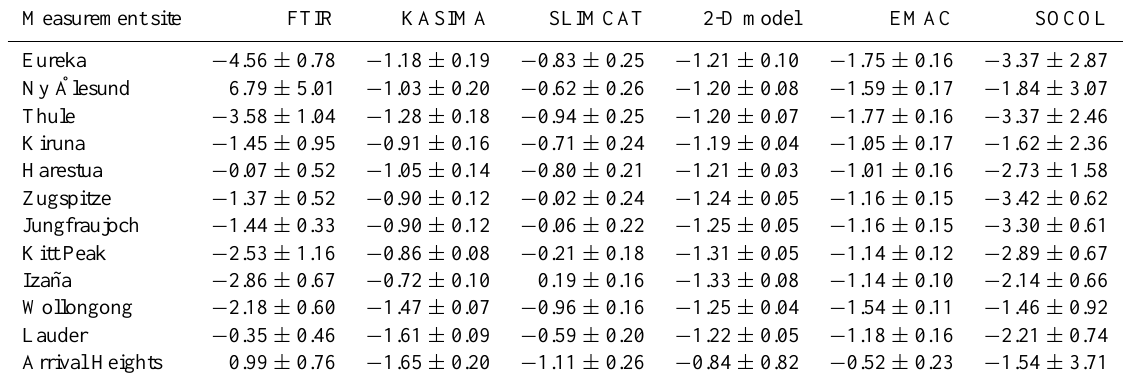
Table 5. ClONO 2 trend in % per year between 2000 and 2009, calculated by fitting a linear function combined with a first (sites poleward of 70°) or third order Fourier series to the data. The error bars were determined with the bootstrap